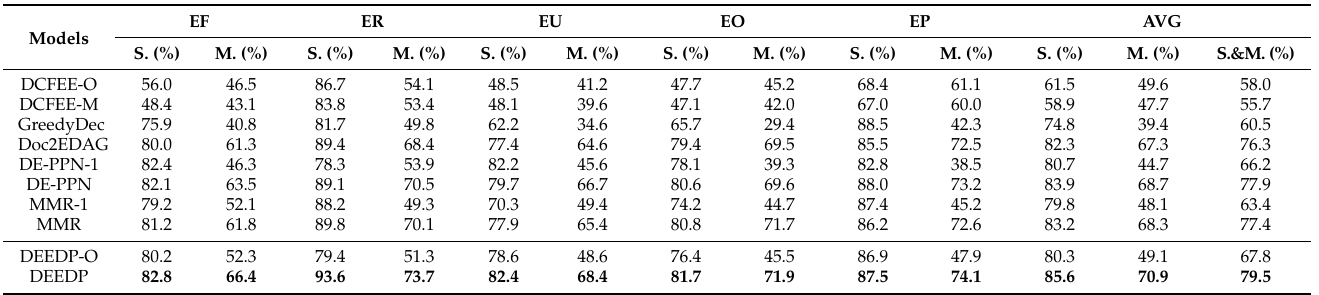
Table 4. F1 scores for each pre-defined event type and the averaged ones (Avg.) on single-event (S.) and multi-event (M.) sets.